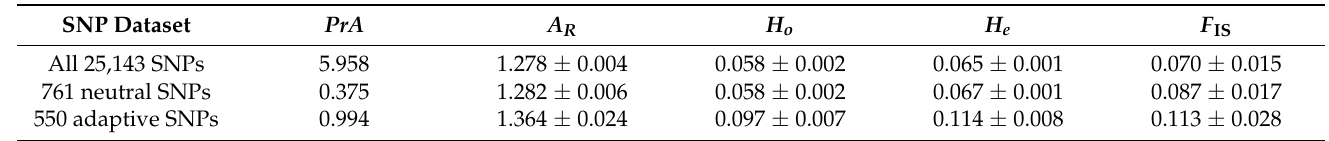
Table 5. Mean genetic variation parameters for 24 population samples of Siberian larch based on three different SNP datasets ( ±